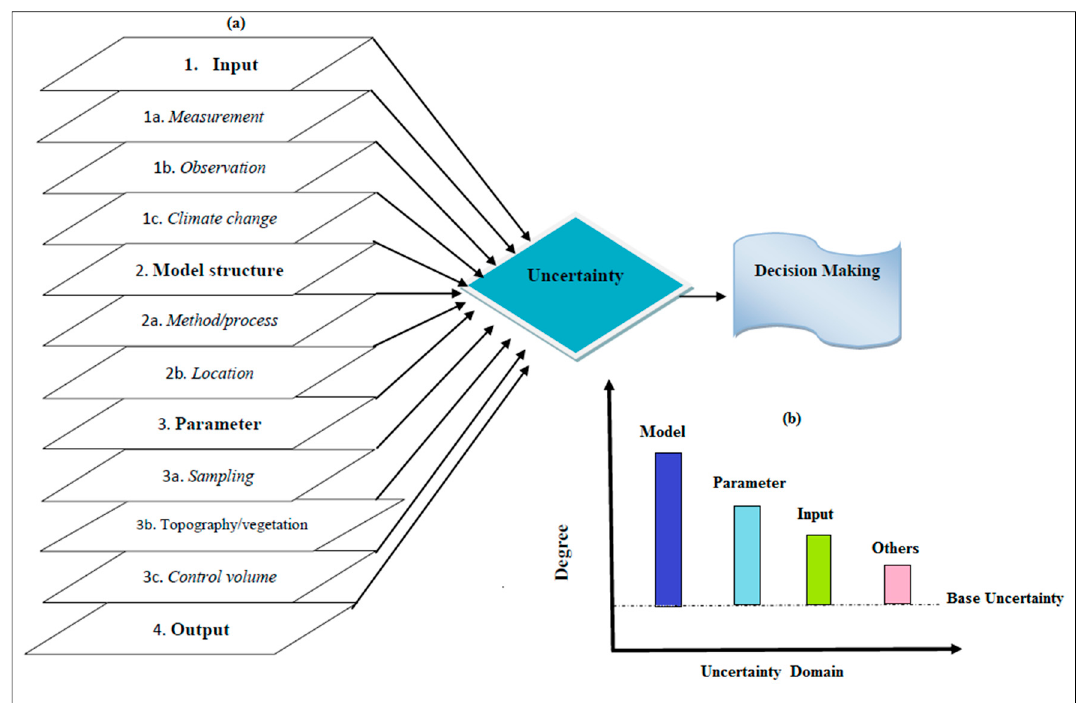
Figure 1. ( a ) Dimensions of uncertainty sources. ( b ) Probable degree of uncertainty in